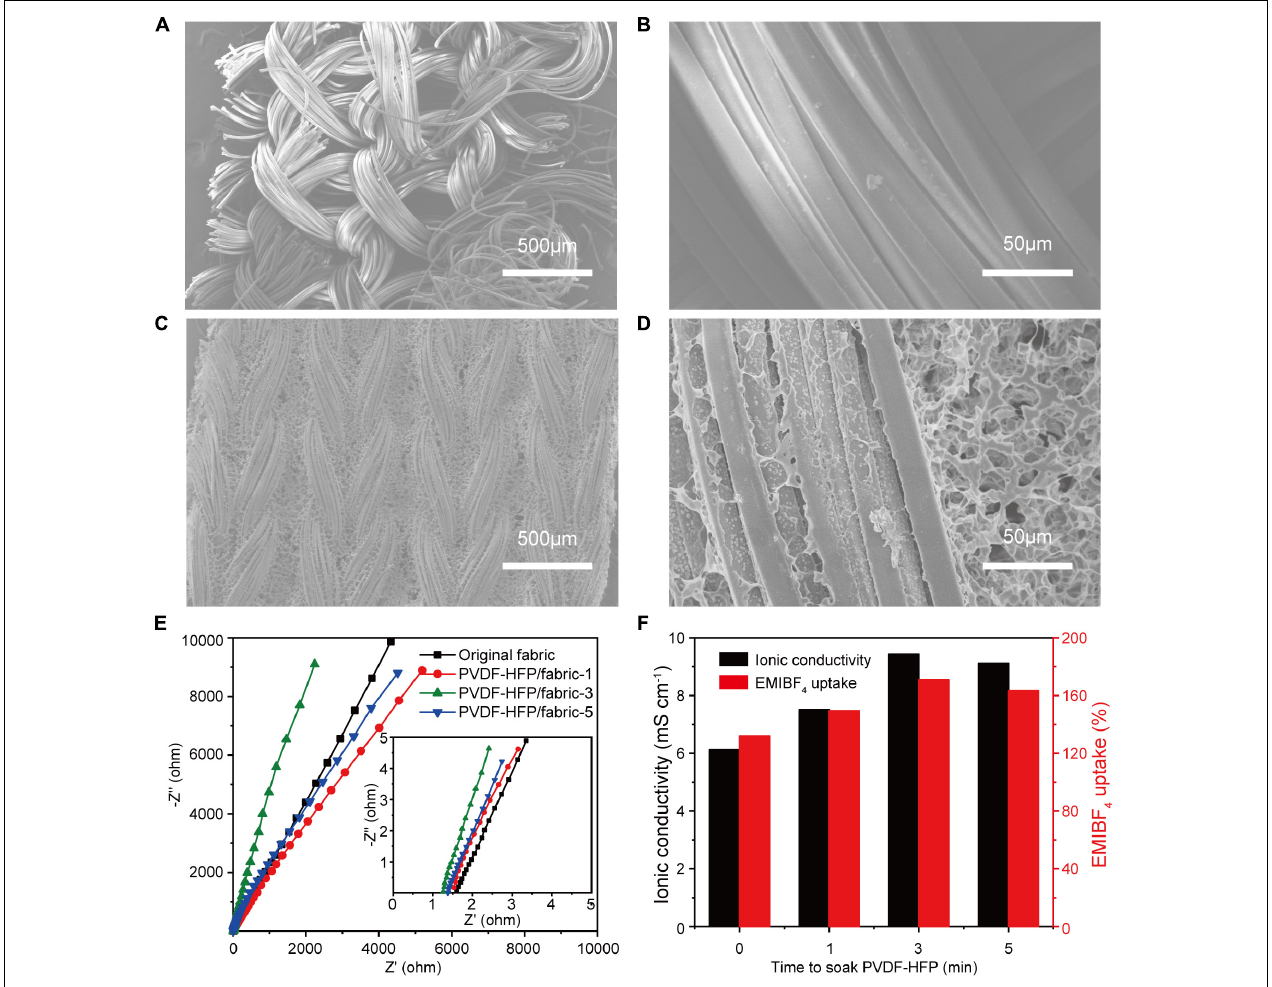
FIGURE 4 | (A,B) The surface morphology of polyester fabric at different magnification. (C,D) The surface morphology of polyester fabric after immersion in PVDF-HFP at different magnification. (E) Nyquist plots of fabric intermediate layer immersed at different times. (F) Ionic conductivity and EMIBF 4 uptake of fabric layer soaked at different times.